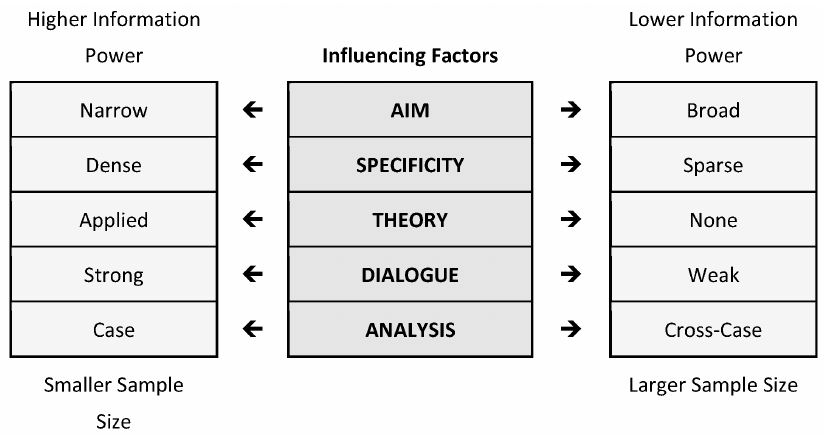
Figure 2. Information power adapted from Malterud et al.